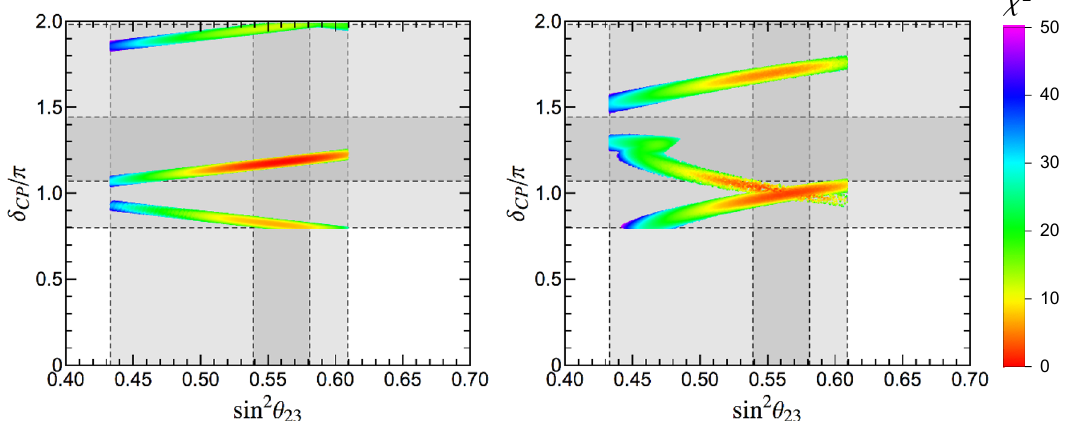
Figure 1 . The correlation between (cid:14) CP and sin 2 (cid:18) 23 , the left and right panels are for the models S 4 with k N = 3 and W 1 with k L = 3 respectively in the charged lepton diagonal basis. The gray bands denote the experimentally preferred 1 (cid:27) and 3 (cid:27) ranges of (cid:14) CP and sin 2 (cid:18) 23 adapted from